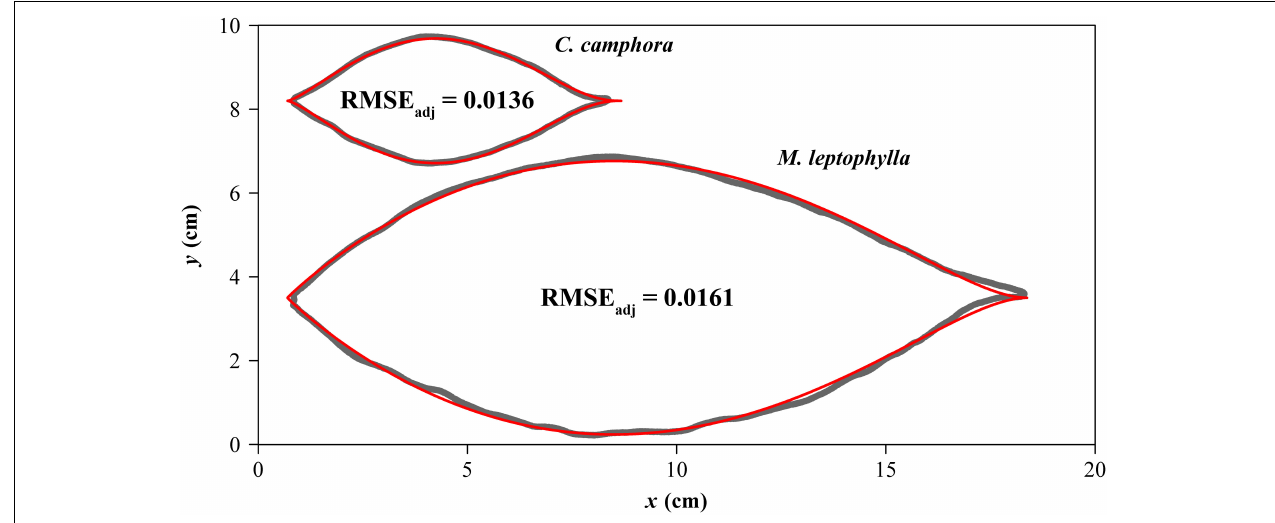
FIGURE 4 | Comparisons between the scanned leaf edges (gray curves) and the leaf edges predicted by the MLRF equation (red curves) for one leaf example each of Cinnamomum camphora (L.) Presl and Machilus leptophylla Hand.-Mazz. The adjusted root-mean-square error (RMSE adj ) is used to reflect the goodness of